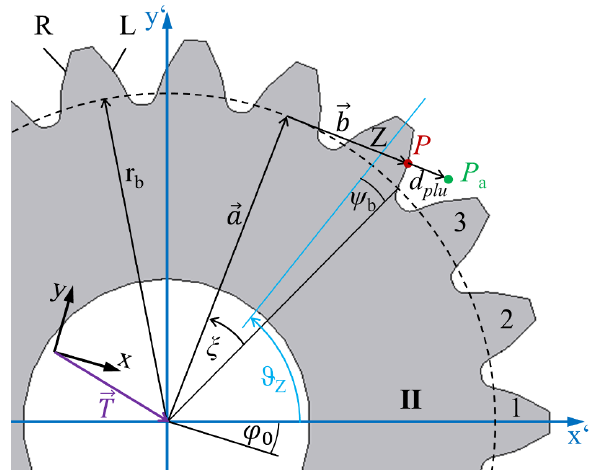
Figure 1. Geometric model of a spur gear for the determination of the base circle radius r b , based on a measuring point P a , the root point P for the plumb line distance d plu and the corresponding rolling angle ξ within the workpiece coordinate system ( x (cid:48) , y (cid:48)